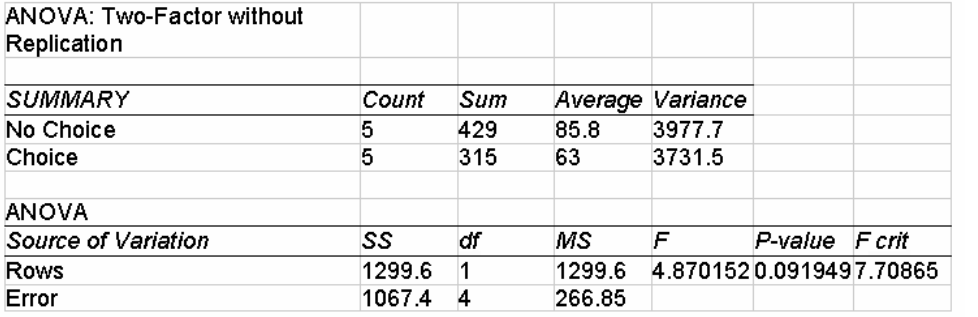
Table 3. Student retention of "Choice" and "No Choice"